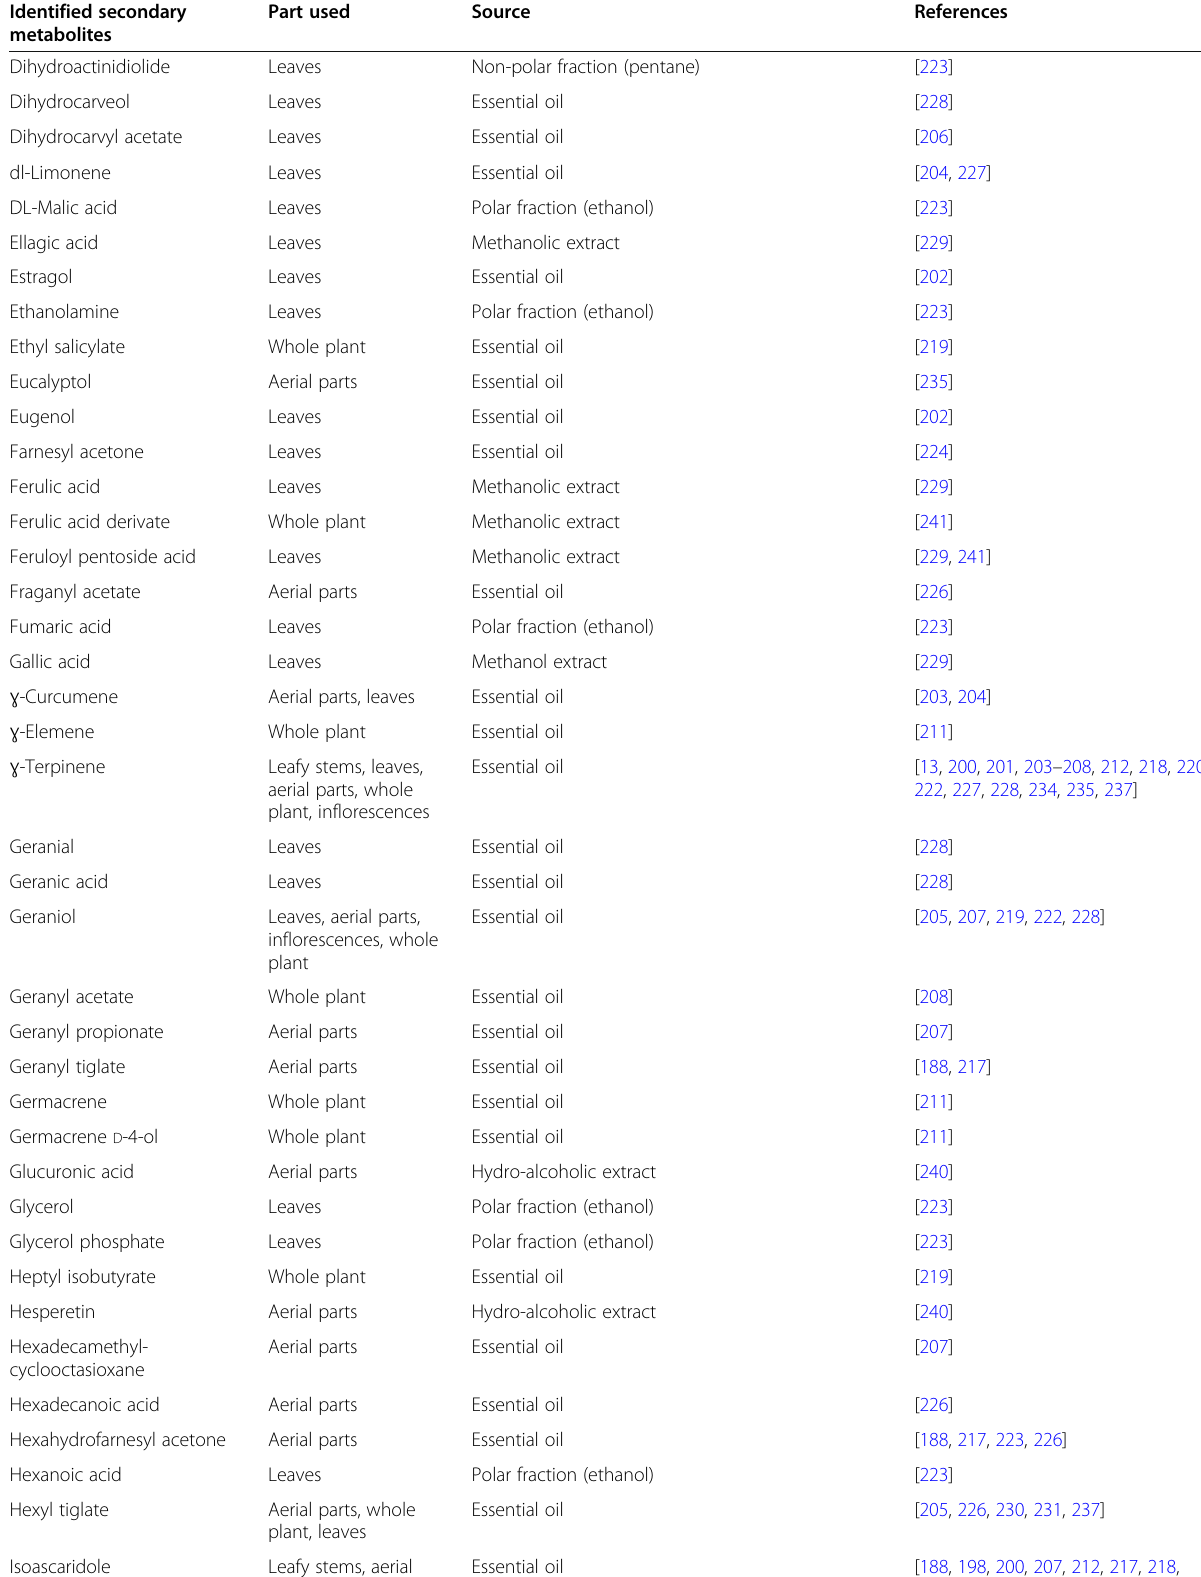
Table 3 Main secondary metabolites identified in C. ambrosioides